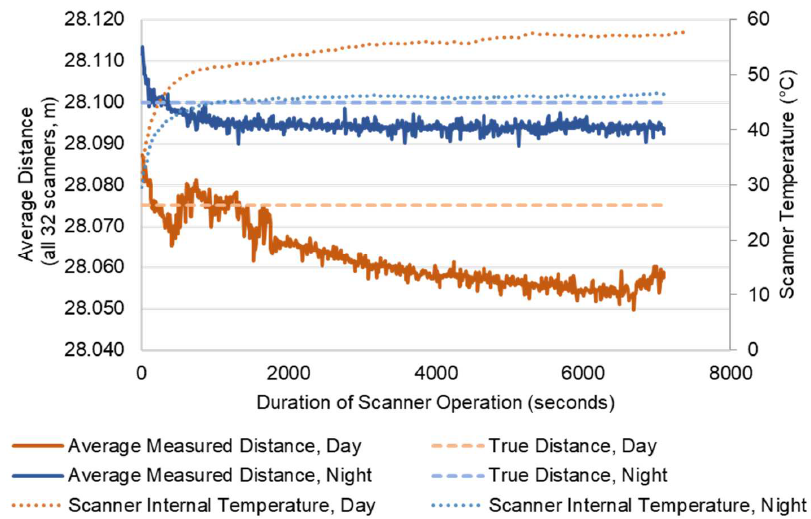
Figure 37. Accuracy of Velodyne ® HDL–32E over time in night and day outdoor experiments. Shift in measured and “true” distance between night and day experiments is the result of minor adjustments made to scanner position after night iteration.